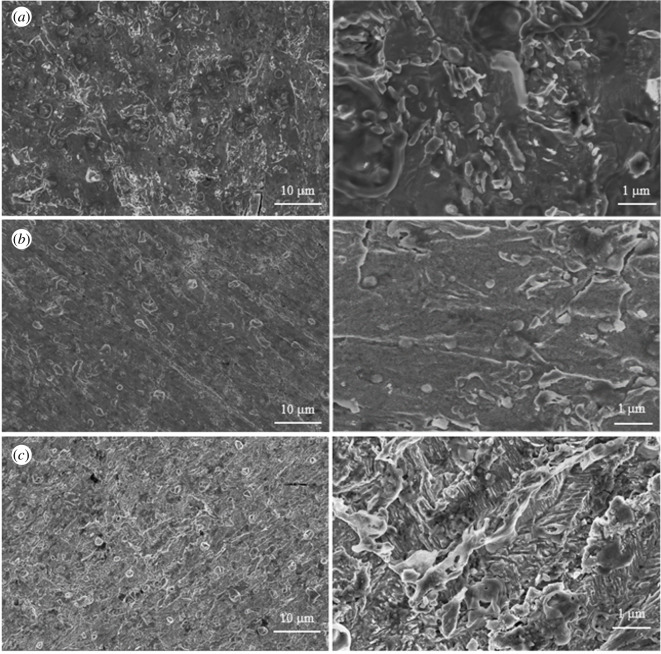
Corrosion morphology of N80 in absence and presence inhibitors: (a) 0.5 M HCl solution, (b) 0.5 M HCl solution + 10 mM PPAPO and (c) 0.5 M HCl solution + 10 mM PPAPO + 3 mM Na2WO4.